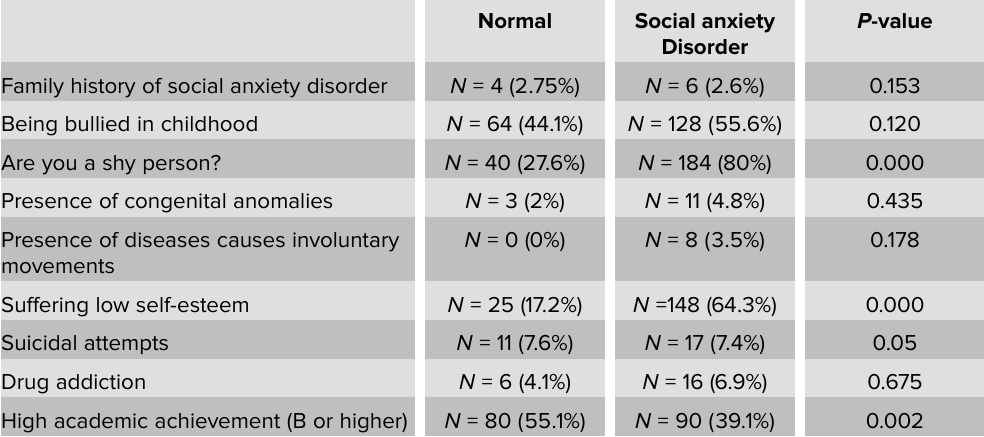
TABLE 2: Associated factors of SAD.